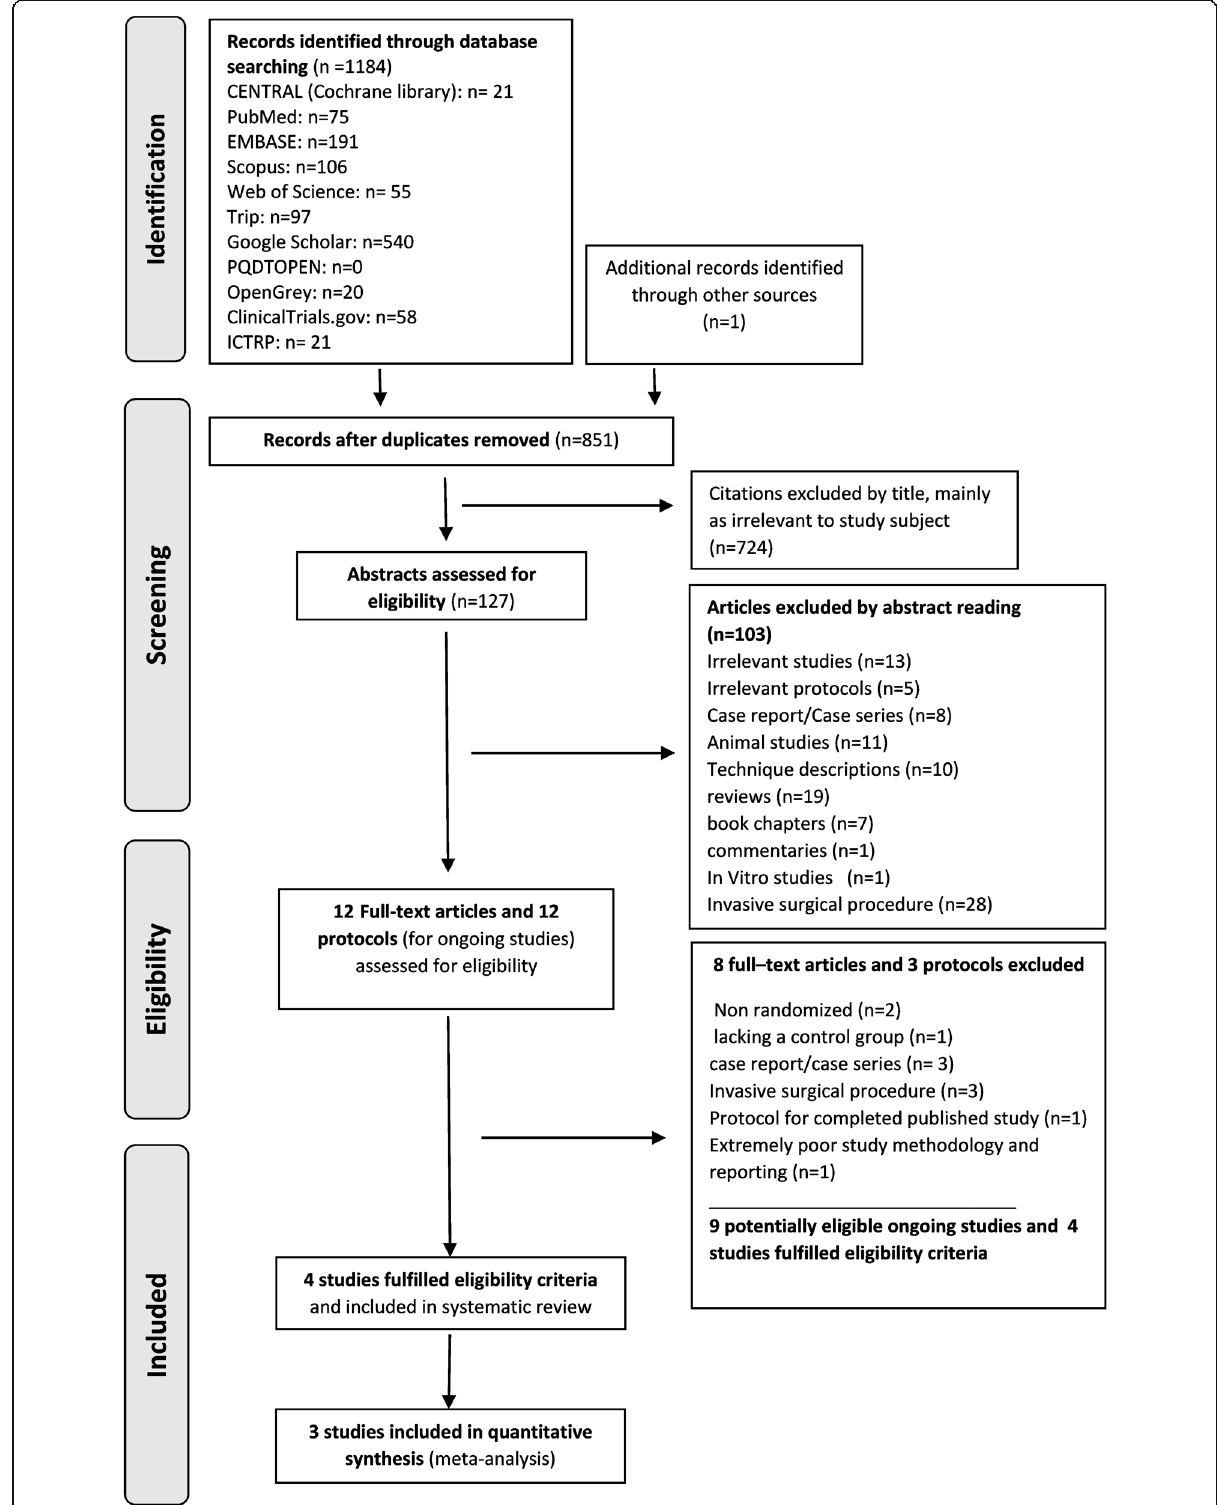
Fig. 1 PRISMA 2009 flow diagram of the included